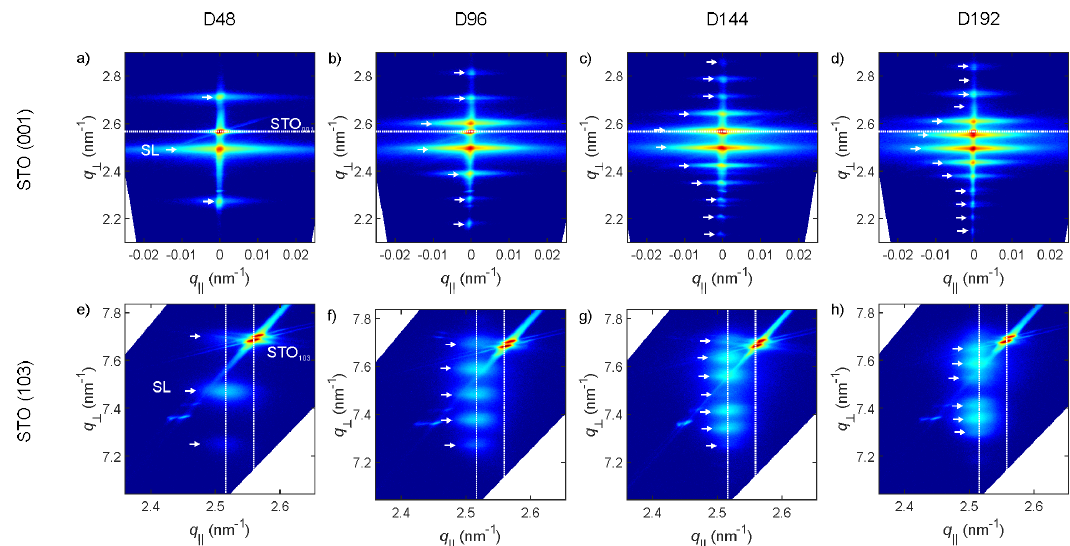
Figure 2. Reciprocal space map (RSM) around the STO 001 ( a – d ) and 103 ( e – h ) peaks for samples D48 ( a , e ), P96 ( b , f ), D144 ( c , g ), and D192 ( d , i ). The white arrows mark the positions of superlattice peaks, the horizontal line in ( a – d ) marks the out-of-plane position of the STO (001) peak, the vertical lines in ( e – g ) mark the in-plane position of the superlattice and STO (103) peaks, respectively, as labeled in ( e